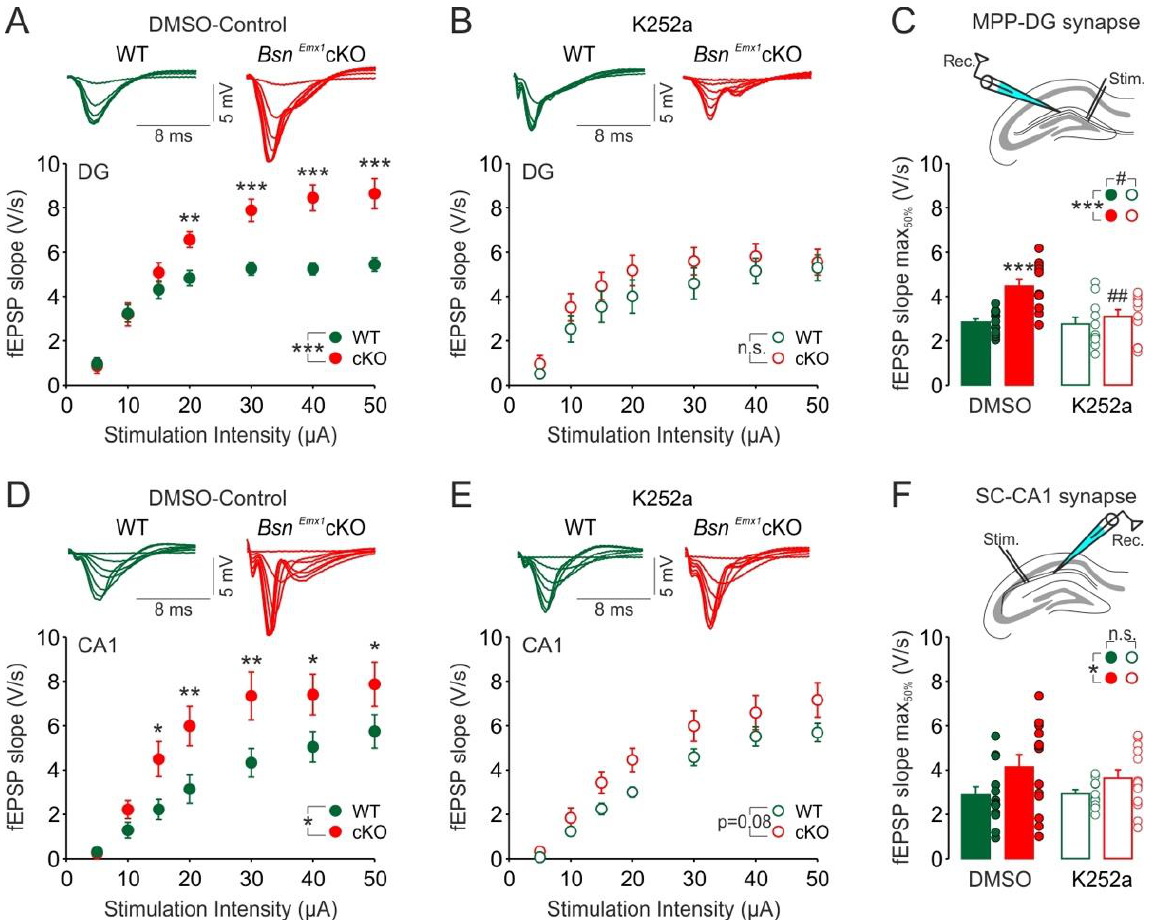
Figure 2. Enhanced hippocampal synaptic excitability in the adult (~3–5 months-old) Bsn Emx1 cKO mice can be normalized by TrkB receptor blockade. Input-Output (I-O) curves showing ( A ) increased field excitatory postsynaptic potential (fEPSP) responses at the medial perforant path-to-dentate gyrus (MPP-DG) synapse of Bsn Emx1 cKO mice and ( B ) its normalization by K252a (200 nM), tyrosine receptor kinase B (TrkB) blocker. ( C ) Two-way ANOVA comparison of fEPSP slopes corresponding to 50% of maximum response revealed a strong genotype and K252a treatment effect at the MPP-DG synapse indicating that TrkB blockade rescues enhanced excitability at the MPP-DG synapse. The positioning of the recording (Rec.) and stimulation (Stim.) electrodes for the MPP-DG synapse is depicted above the summary graph. I-O curves showing ( D ) enhanced fEPSP responses at the Schaffer collateral-to-CA1 (SC-CA1) synapse of Bsn Emx1 cKO mice and ( E ) its partial normalization by TrkB blockade. Note the lack of genotype effect, but a persistent tendency for increased fEPSP responses in the Bsn Emx1 cKO mice in comparison to WT mice under the blockade of TrkB signalling. ( F ) Comparison of fEPSP slopes corresponding to 50% of maximum response shows only a genotype effect without any K252a treatment effect indicating that K252a did not reduce fEPSP slopes significantly at the SC-CA1 synapse of the Bsn Emx1 cKO mice. The positioning of the recording (Rec.) and stimulation (Stim.) electrodes for the SC-CA1 synapse is depicted above the summary graph. Merged traces to increasing stimulation strengths (5–50 µ A) for each condition are depicted above the I-O curves (WT: Green; Bsn Emx1 cKO: Red). slices were pre-treated (2 h) either with vehicle DMSO (DG-WT: N = 4 mice, n = 13 slices; DG- Bsn Emx1 cKO: N = 4 mice, n = 11 slices; CA1-WT: N = 4 mice, n = 13 slices; CA1- Bsn Emx1 cKO: N = 4 mice, n = 13 slices) or K252a (DG-WT: N = 4 mice, n = 11 slices; DG- Bsn Emx1 cKO: N = 4 mice, n = 11 slices; CA1-WT: N = 4 mice, n = 13 slices; CA1- Bsn Emx1 cKO: N = 4 mice, n = 10 slices). * indicates a significant genotype effect (* p < 0.05; ** p < 0.01: *** p < 0.001) and # indicates a significant K252a treatment effect (# p < 0.05; ## p < 0.01). n.s. indicates not significant. Two-way repeated ANOVA followed by posthoc comparison using Fisher LSD Method was performed for ( A , B , D , E ). Two-way ANOVA followed by posthoc comparison using Fisher LSD Method was performed for ( C , F ). All values are expressed as mean ±